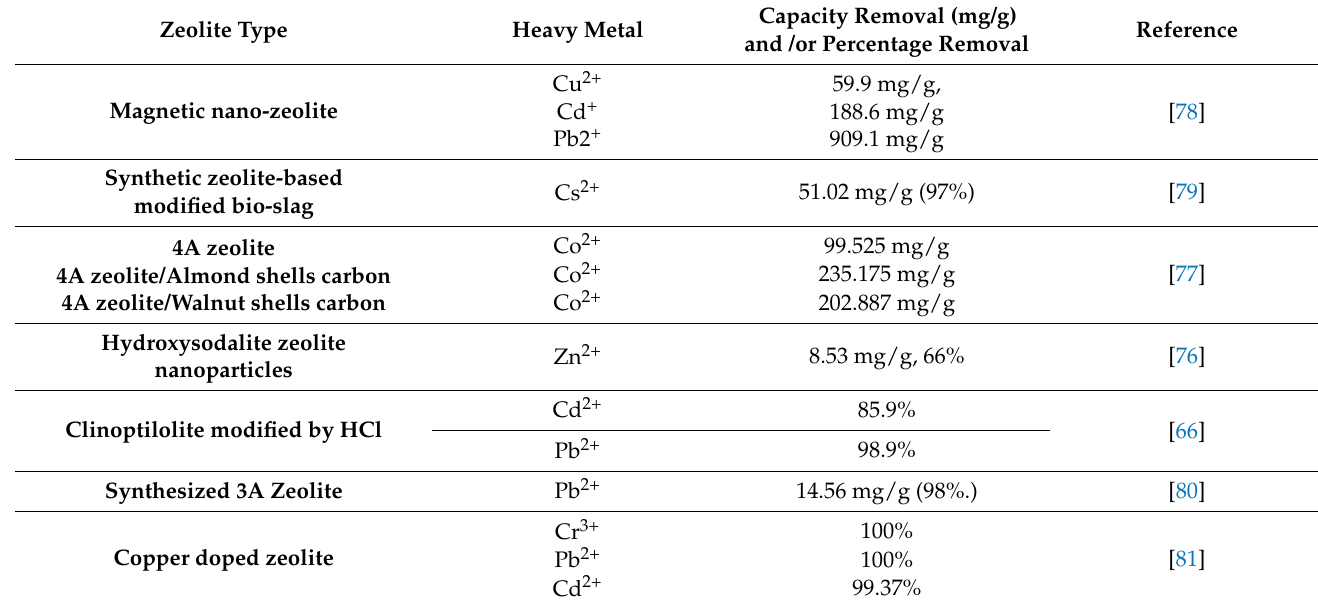
Table 2. Some latest applications of zeolite nanoparticles for heavy metals removal from aquatic